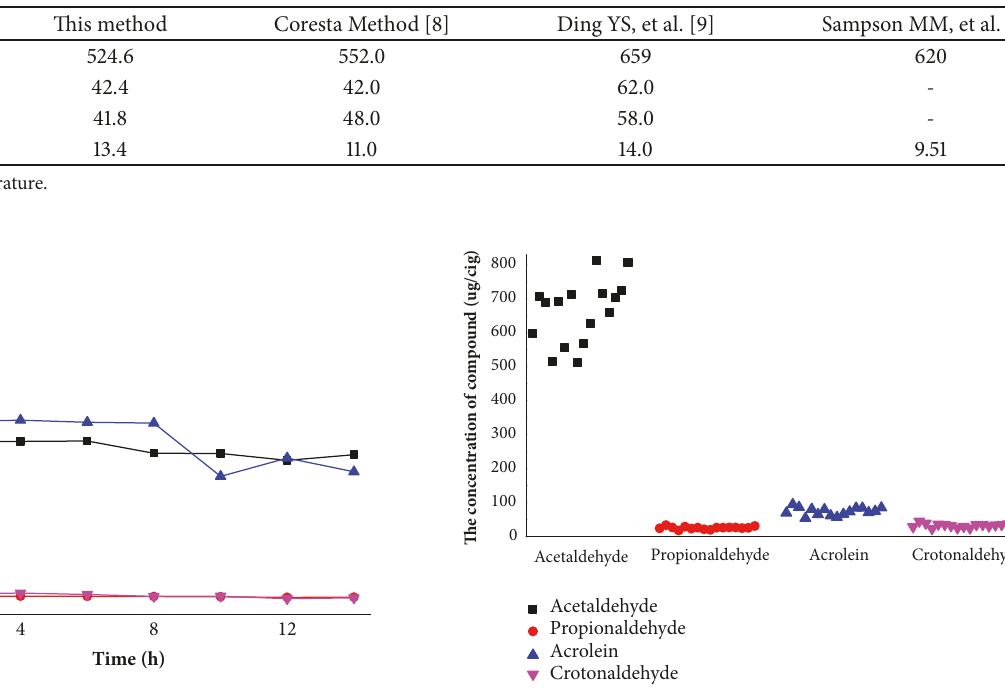
Table 5: Comparison of aldehydes in cigarette smoke with literature values ( 𝜇 g/cig).